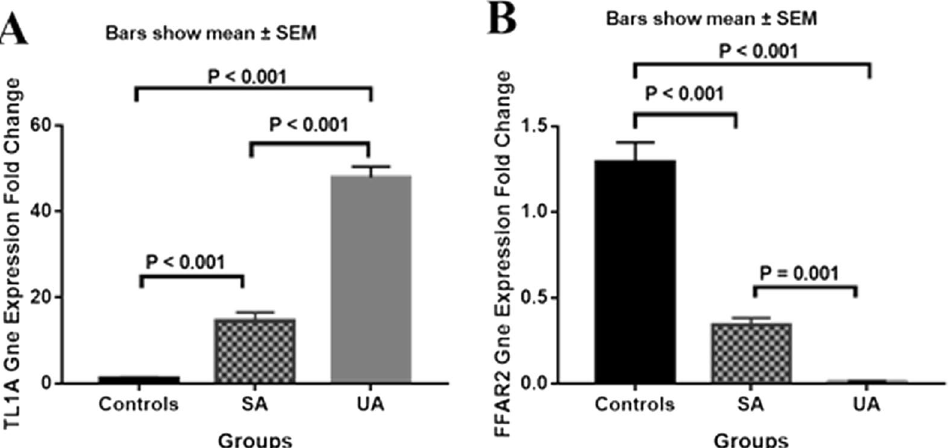
Fig. 1 Fold change gene expression (2^-ΔΔCt) of TL1A and FFAR2 in SA and UA patients and controls. The data are presented as the mean FFAR2 free fatty acid receptor 2, SA stable angina, SEM Standard error of mean, TL1A tumor necrosis factor like cytokine 1A, UA unstable angina, and P value < 0.05 is considered statistically